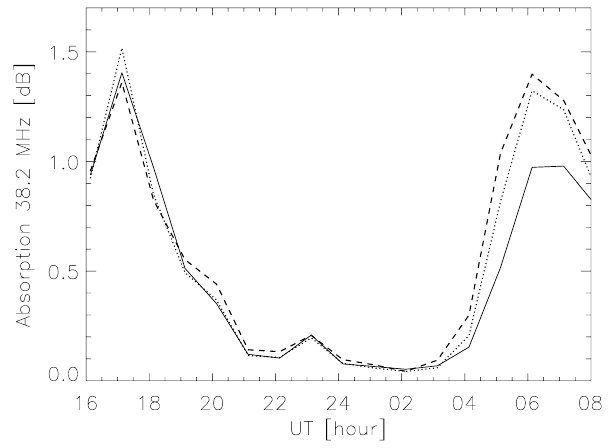
Fig. 3. The cosmic radio noise absorption measured by IRIS in beam 8 (solid line), 15 (dotted line), and 22 (dashed line) from 15:38UT 21 January to 08:38UT 22 January